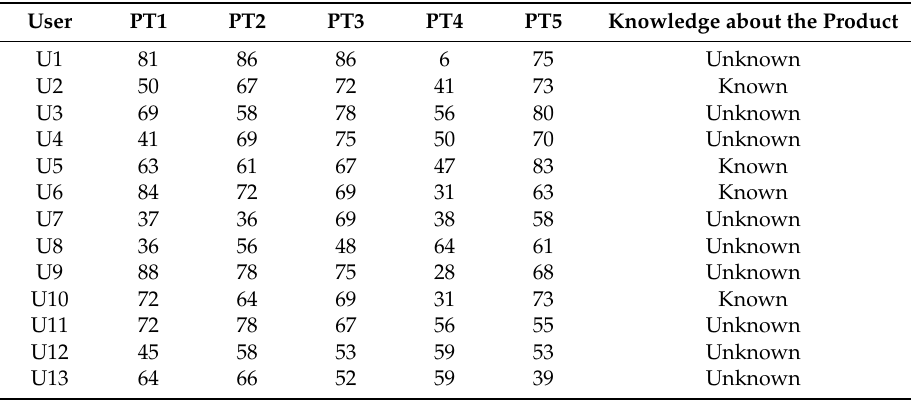
Table 5. Personality and knowledge of the possible